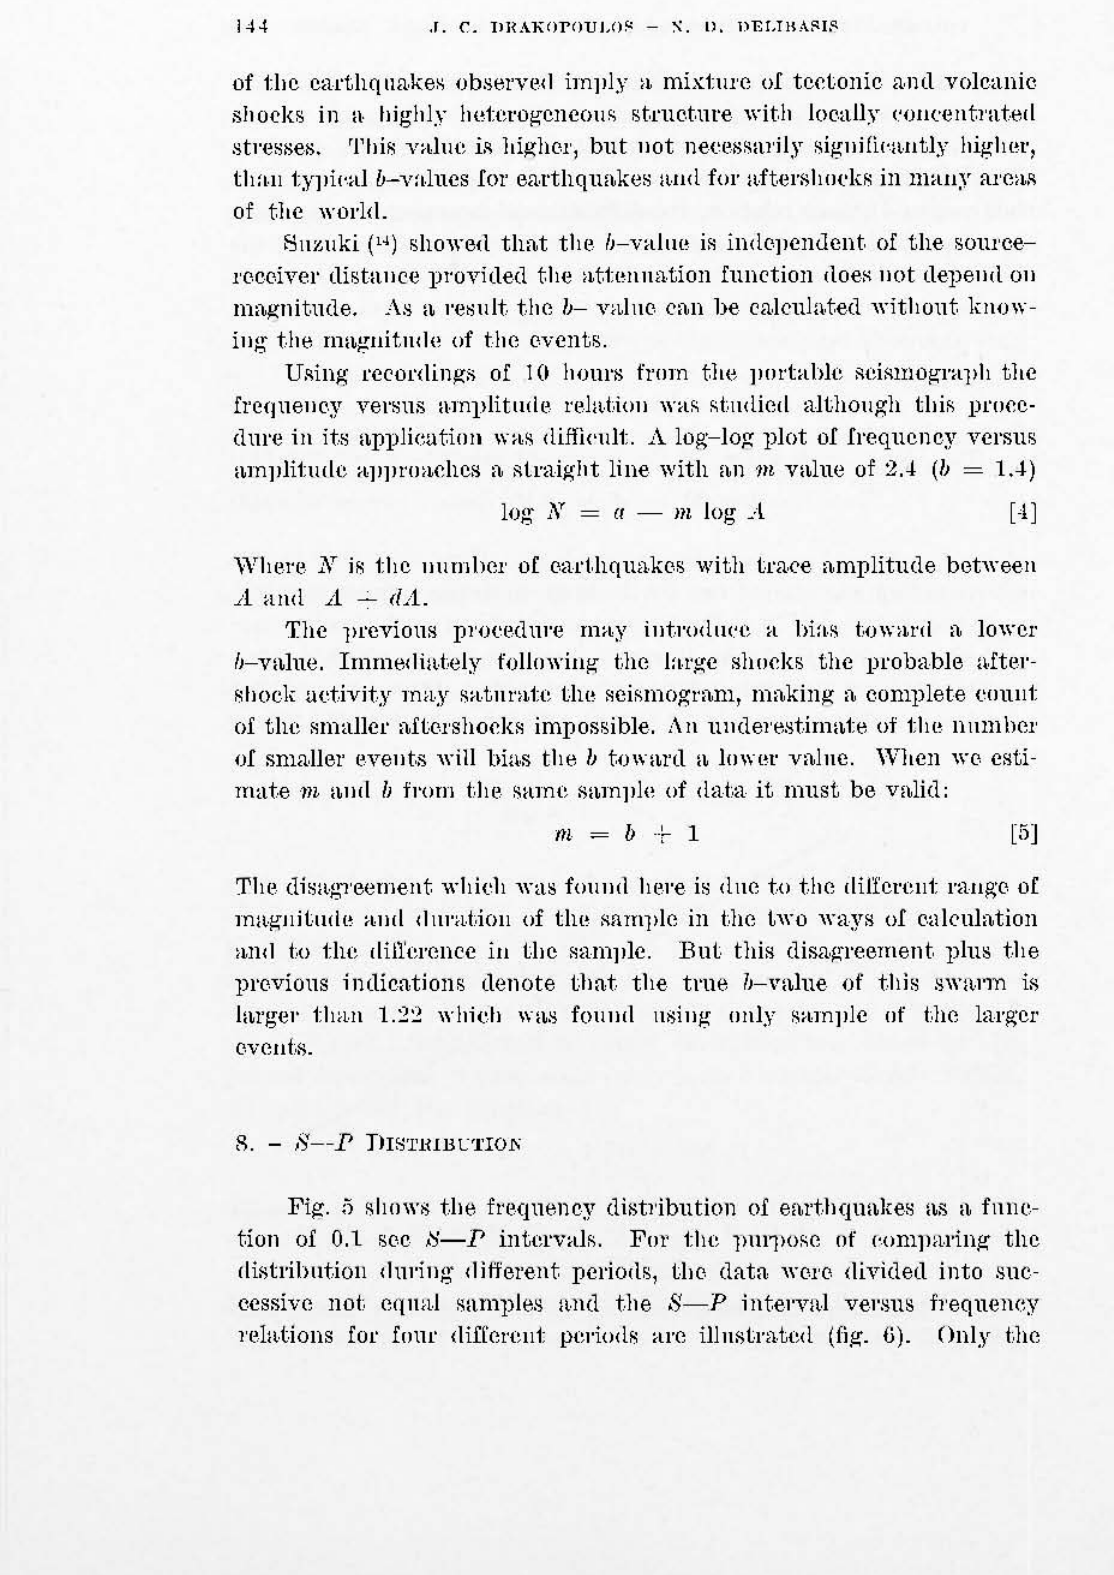
Fig. {j ~ho\\"s the frequency distribution oi earthquakes as a flllle